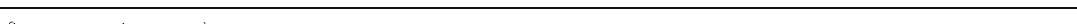
(See figure on previous page.) Fig. 3 White matter hyperintensities (WMH) on FLAIR imaging and corresponding optical coherence tomography (OCT) scans and intensity graphs. a and b Examples of two patients with different extent of WMH on FLAIR imaging (yellow arrows), left Fazekas grade 3, right Fazekas grade 1, respectively. c and d OCT scans showing superior temporal branch of the retinal artery (red arrow: inner wall. Blue arrow: outer wall. Orange line: lumen). e and f intensity graphs showing the inner wall ’ s (red line) and the outer wall ’ s peak (blue line) with space in between (orange line) corresponding to the lumen